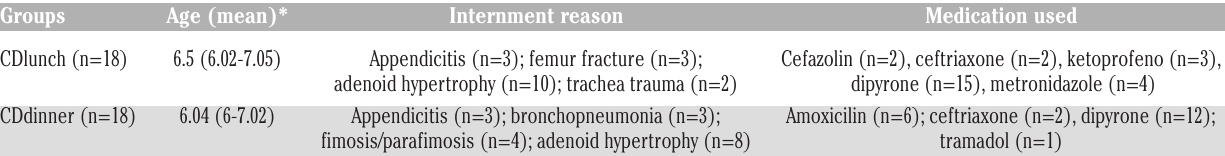
1. Age, internment reason and medication used for the participant children.